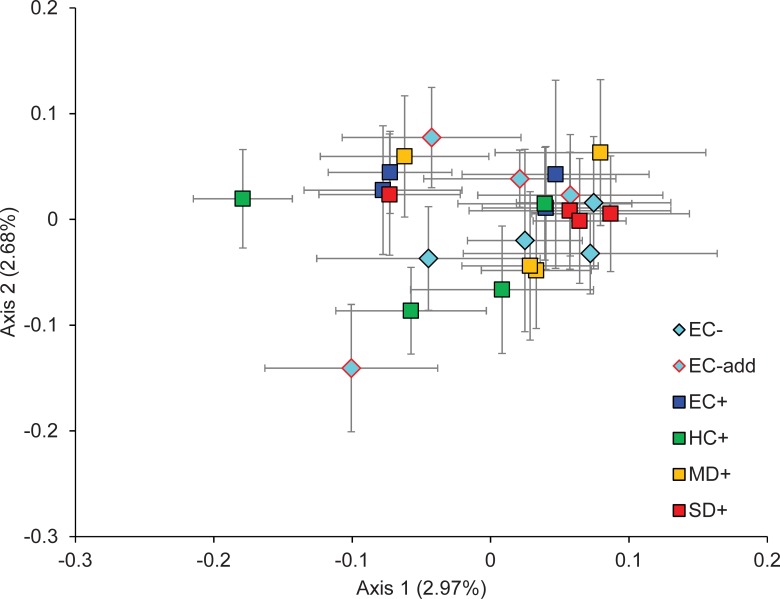
Principal Coordinates Analysis (PCoA) of 24 plots containing 282 individuals of Cistus ladanifer subjected to different treatments of fire and drought, based on 275 AFLP loci.EC: Environmental Control, EC add: additional Environmental Control (see text for details), HC: Historical Control, MD: Moderate Drought, SD: Severe Drought; +/-: fire/no fire. Symbols represent the mean position of all individuals within each plot and error bars represent standard error. Cumulative genetic variation explained by the two depicted axes is 5.66%.